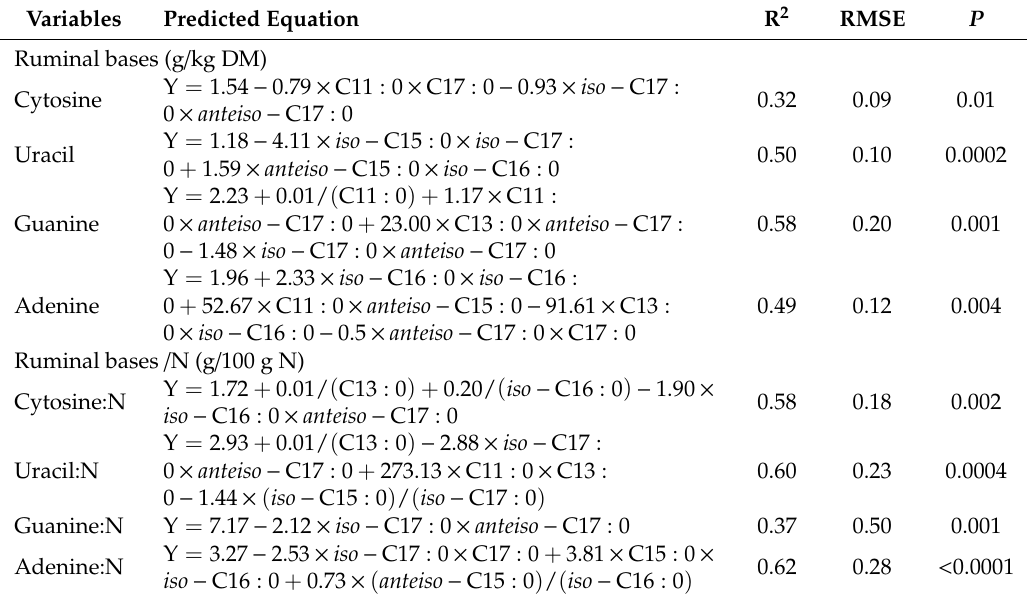
Table 11. Predicted equations of ruminal bacterial bases from milk